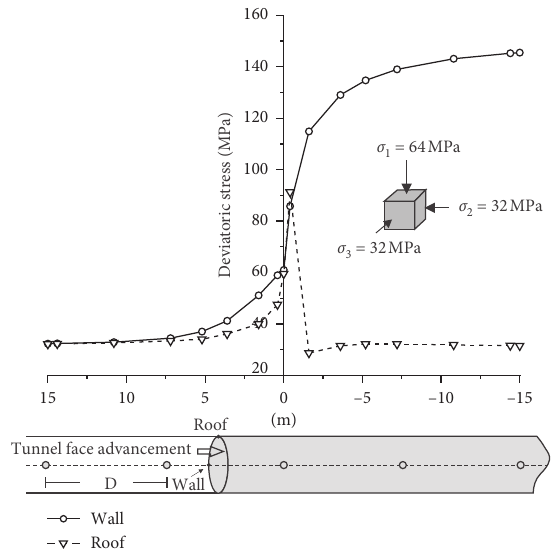
Figure 1: Deviatoric stresses at different locations along the sur- rounding rock (modified from the work of Liu et al., 2013).